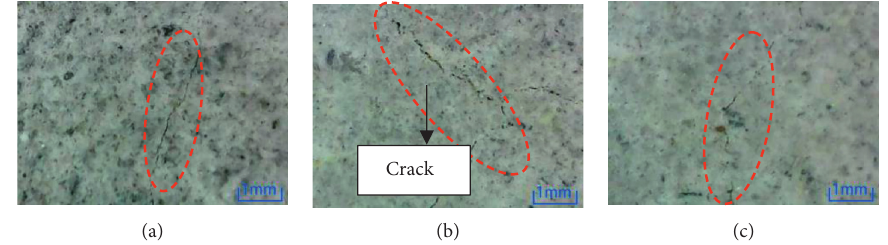
Figure 24: Microscopic observation of specimen soaked in NaCl solution at position 1. (a) 0%. (b) 1%. (c) 2%.